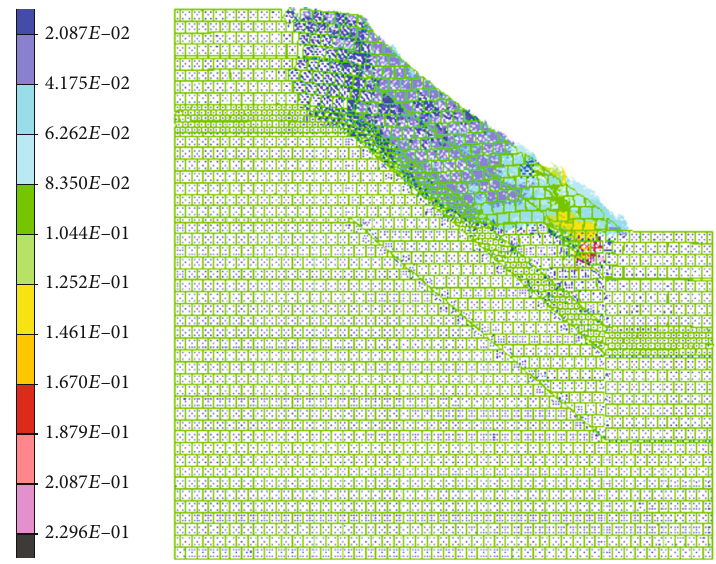
Figure 12: Speed vector diagram when running 160,000